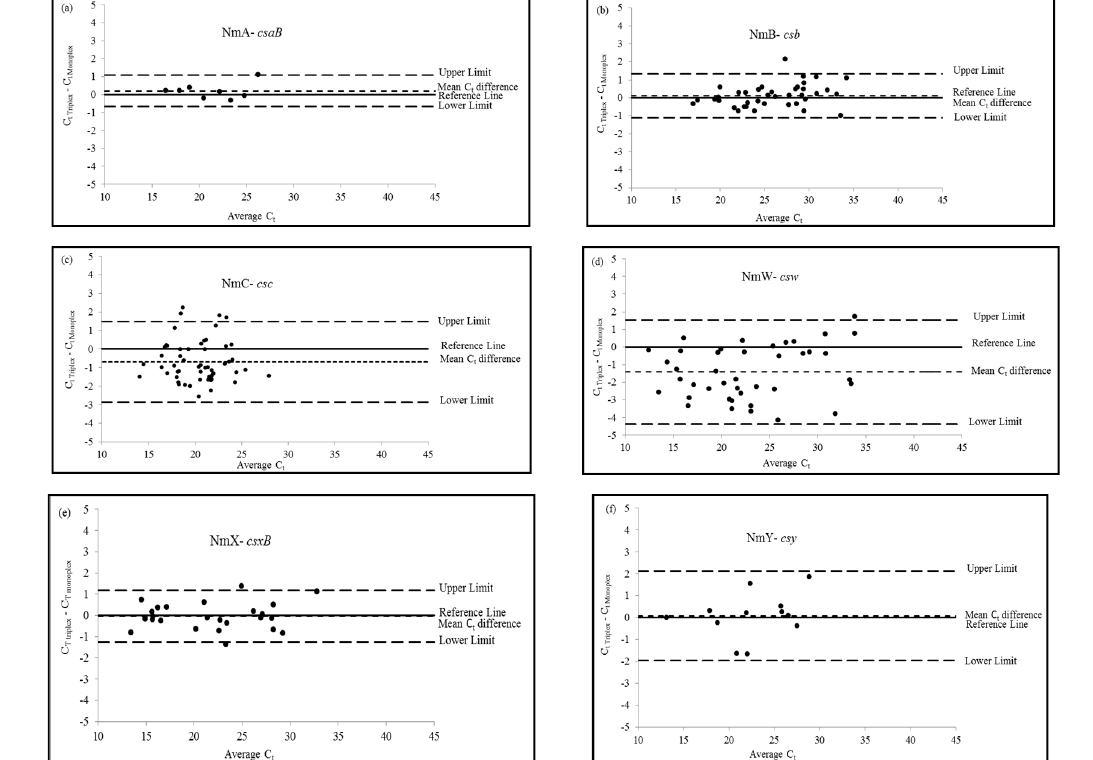
Figure 1. Bland-Altman Plots resulting from the pairwise comparison of C t values between triplex and monoplex direct real-time PCR assays by meningococcal serogroups: ( a ) NmA- csaB ; ( b ) NmB- csb ; ( c ) NmC- csc ; ( d ) NmW- csw ; ( e ) NmX- csxB; and ( f ) Nm- csy . Level of agreement between the two assays by serogroup ( C t Triplex − C t Monoplex ), also known as observed mean difference (small dash line), is presented as a function of the average C t values of the two assays [( C t Triplex + C t Monoplex )/2]. Reference lines (solid line) indicate the ideal zero difference. Upper and lower limits of agreement (large dash lines) defined by mean C t difference +/ − 1.96 × SD.